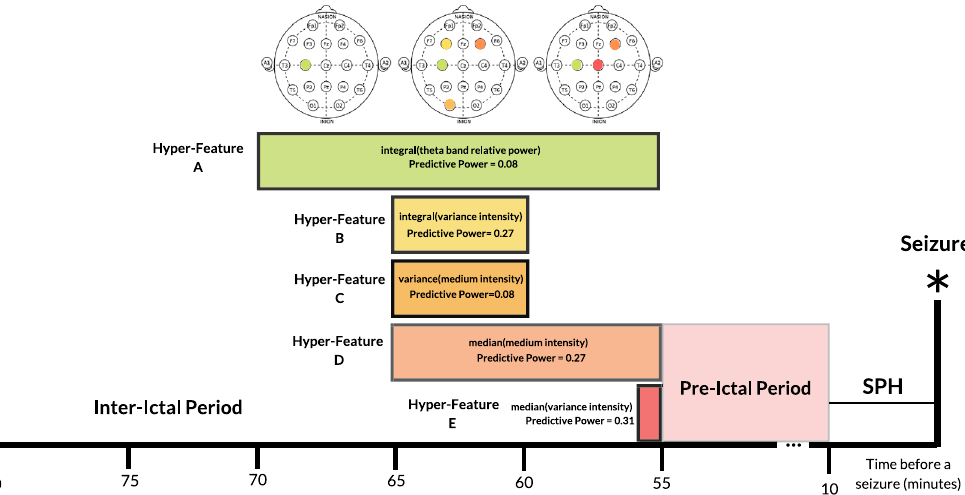
Figure 7. An example of the EA output, for patient 53402, with a pre-ictal period of 55 min, 10-min SPH and a 45-min SOP, where each hyper-feature has a different colour. One can see the sequence of hyper-features: their window length, electrode, feature, and applied mathematical